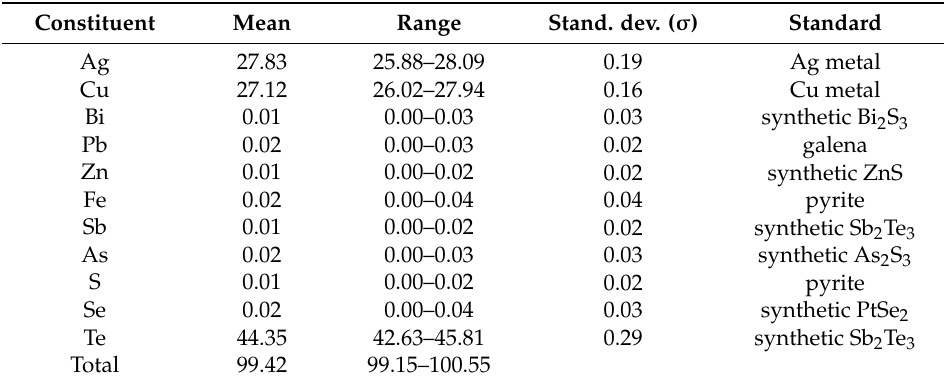
Table 2. Analytical data in wt.% for